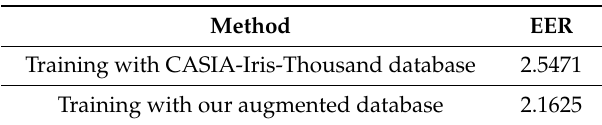
Table 13. Comparative EERs on CASIA-Iris-Distance database in case of training with CASIA-Iris- Thousand database or training with our augmented database (unit: